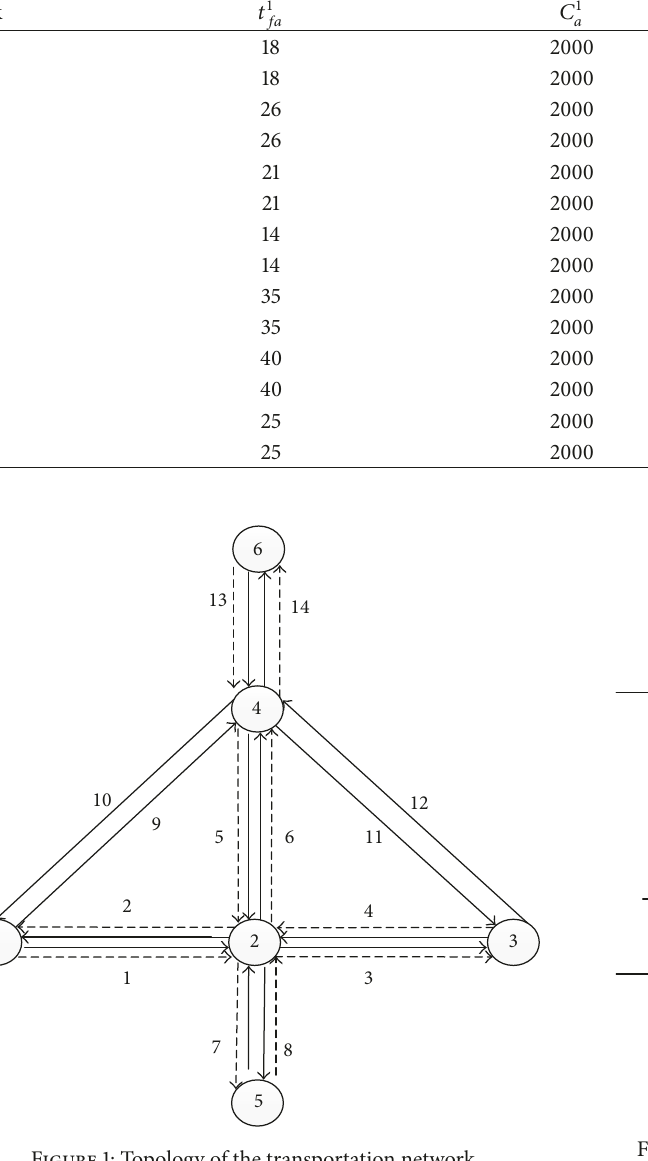
Figure 1: Topology of the transportation network. Figure 2: Illustration of green time ratios in intersection